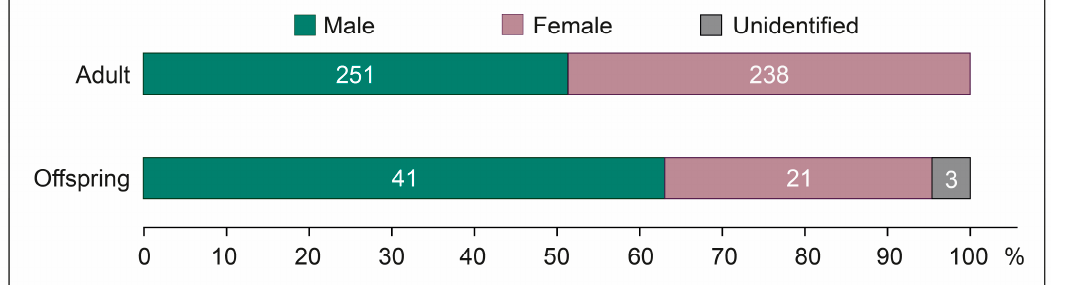
30 min independence interval) obtained in the Northern Pantanal (Mato Grosso, Brazil) from July 2015